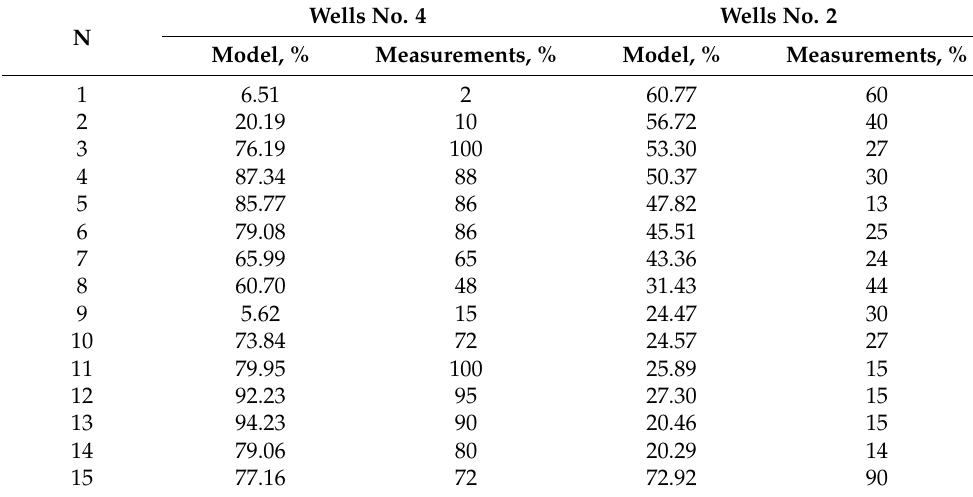
Table 2. An example of a set of actual and model